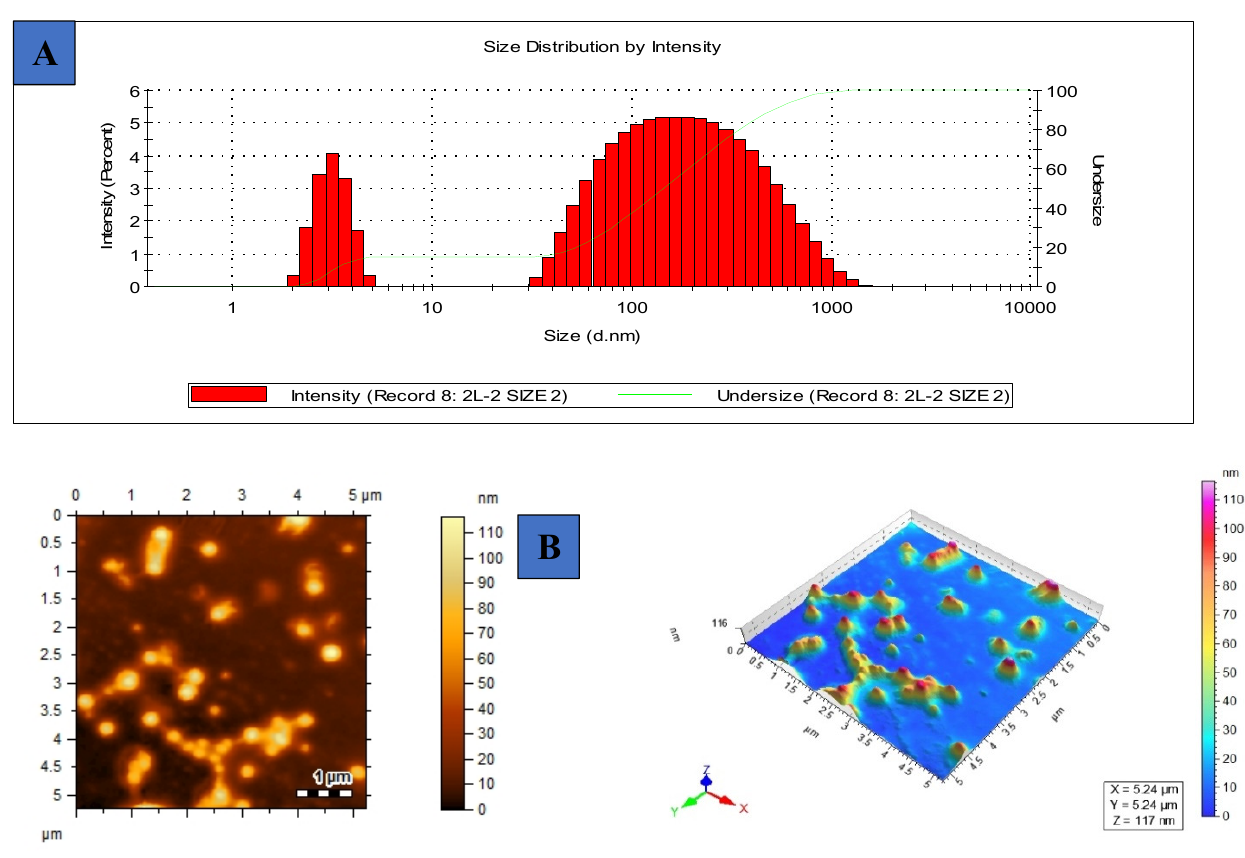
Figure 4. DLS intensity profile: ( A ) average size of [G10a] 3 -SHa using Zetasizer, ( B ) atomic force microscopic image of [G10a] 3 -SHa.